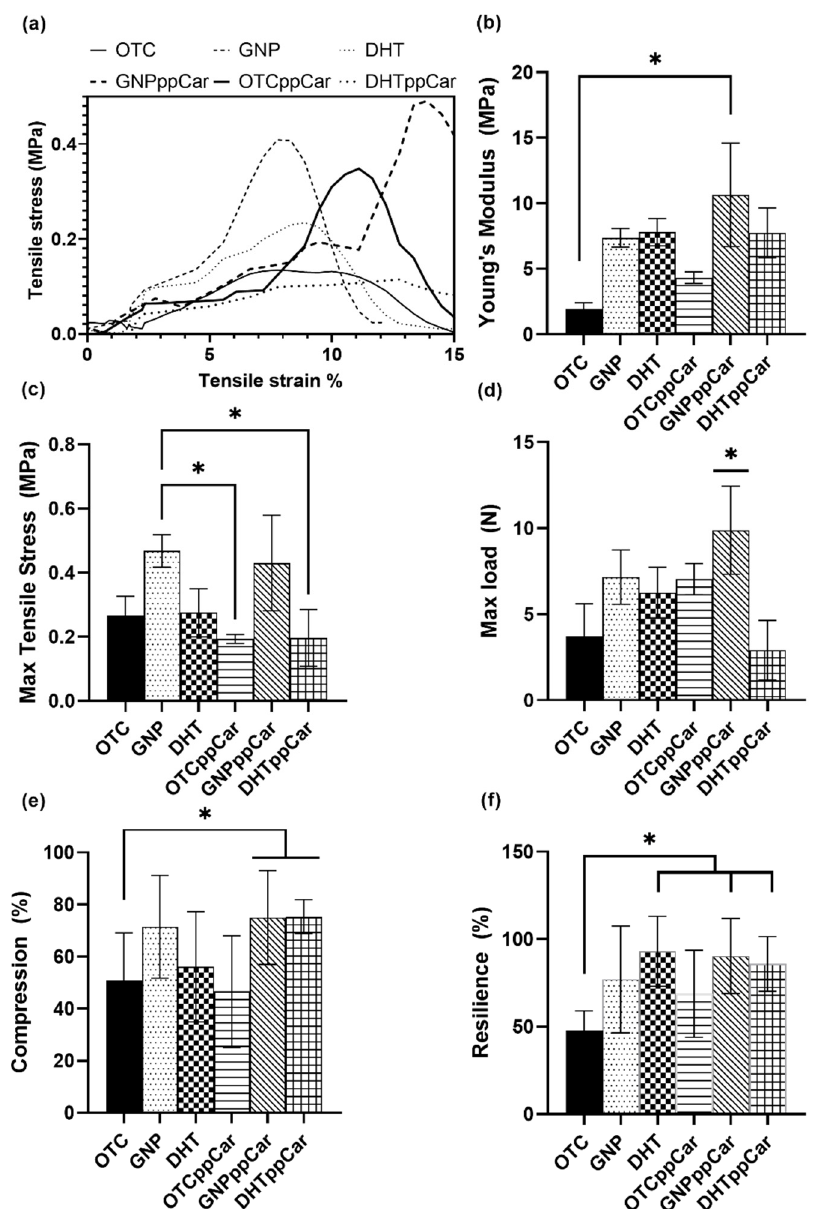
Figure 4. The mechanical characterisation of the scaffolds at room temperature includes ( a ) stress vs. strain curve, ( b ) Young’s modulus, ( c ) max tensile stress, ( d ) max tensile load, ( e ) compression test and ( f ) resilience test. * p ≤ 0.05 indicates significant differences in the fabricated materials.